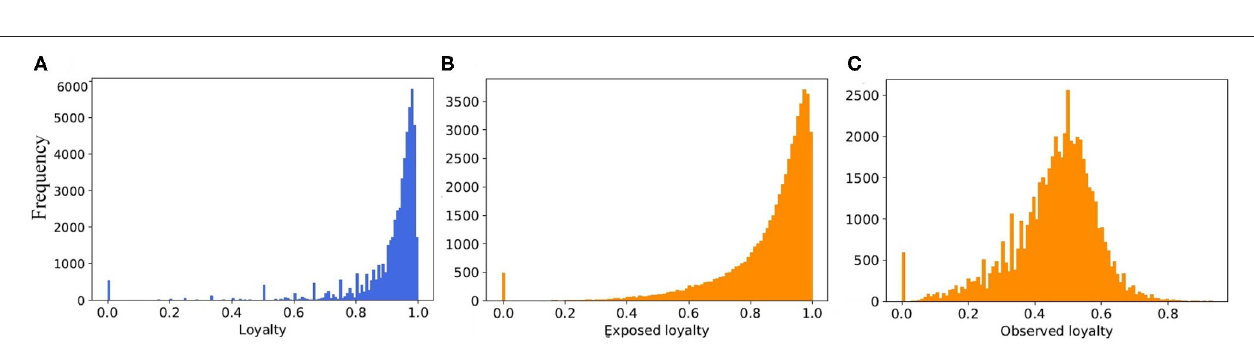
FIGURE 11 | The distribution of loyalty value (A) computed from the real dataset, (B) generated from the fitted probability function in the model, and (C) computed from the output of the model.